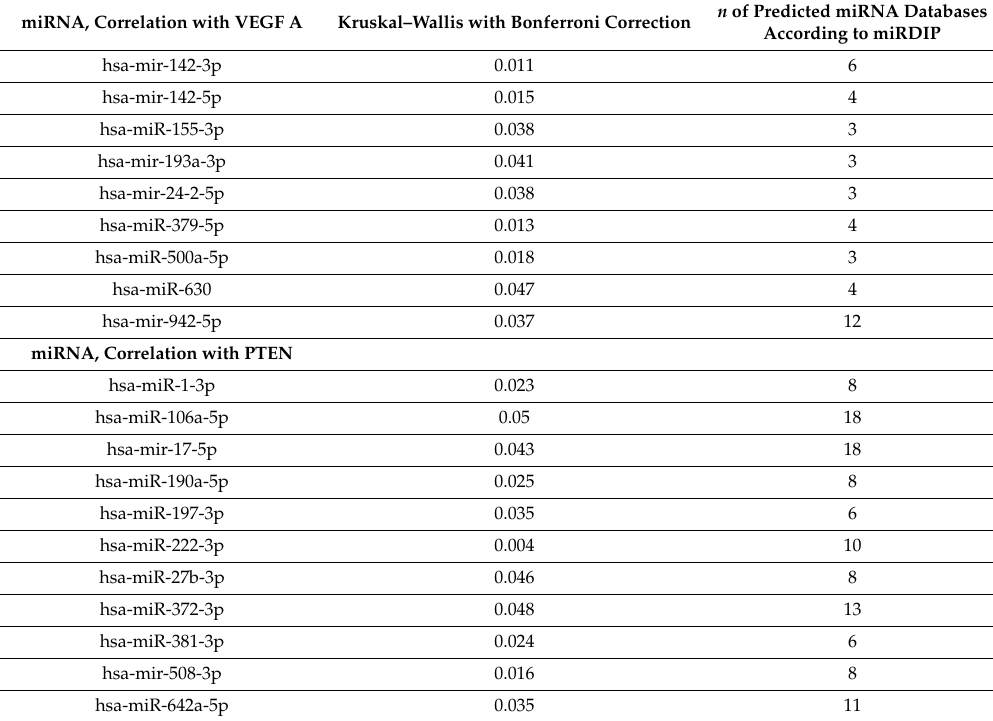
Table 4. Correlation of VEGF and PTEN immunohistochemistry with miRNA expression and nr of miRNA Databases, predicting these interactions.